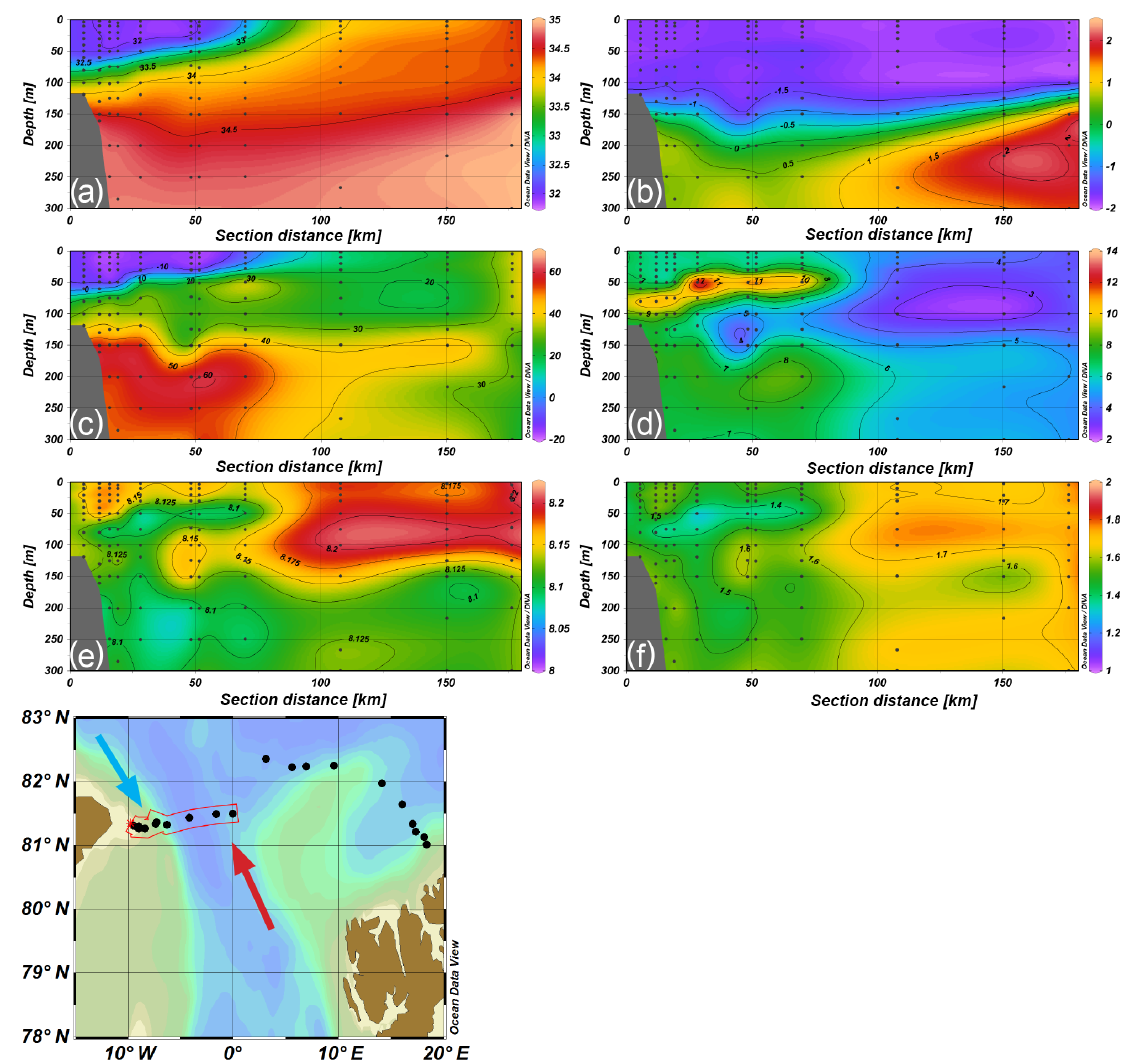
Figure 6. Sections of (a) salinity, (b) temperature, (c) AOU, (d) SiO 2 , (e) pH tot about 81.5 ◦ N from the Yermak Plateau to Greenland as noted on the map, collected in May 2002. The arrows illustrate the north-flowing warm Atlantic and the south-flowing cold Arctic surface